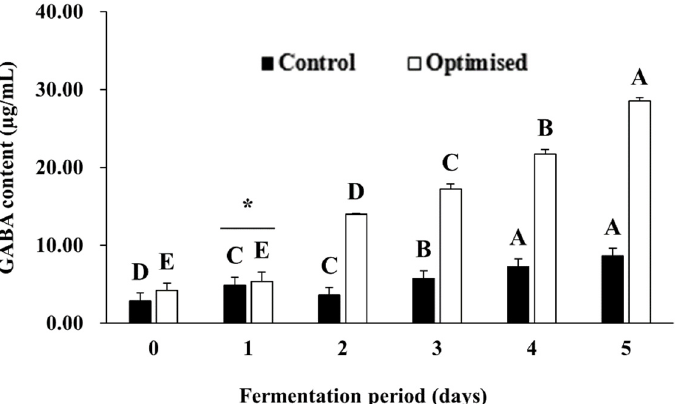
Figure 4. Changes in GABA content of LFG before and after fermentation optimisation. ■ : control (fermentation under non-optimal conditions), □ : optimised (fermentation with supplementation of 1% MSG along with optimal conditions in Figure 3). MSG was supplemented to enhance GABA production based on previous articles [56–59]. Values of bars in the same color with different letters (A–E) are significantly different ( p < 0.05). * Asterisk represents a statistically insignificant difference between the values of the two bars in the same fermentation period ( p > 0.05), while pairs of bars without an asterisk indicate a significant difference ( p < 0.05). Error bars indicate standard deviations determined from triplicate experiments.